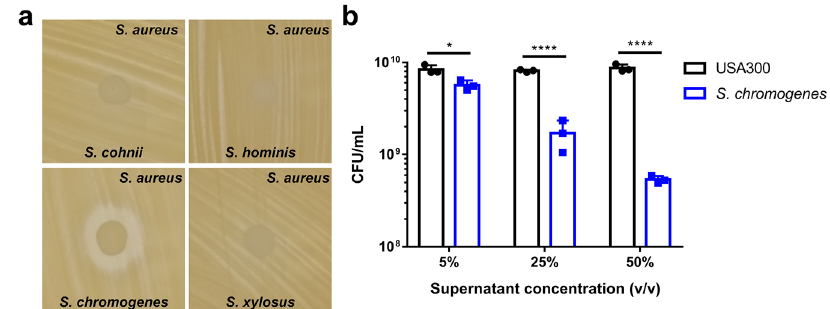
Fig. 1 S. chromogenes secretes a molecule that inhibits S. aureus growth. a Simultaneous antagonism assay of selected representative CoNS on TSA. b S. aureus was cultured in TSB containing spent culture supernatant from S. chromogenes or S. aureus . The bacteria were grown for 24 h before they were plated and CFU/mL were enumerated. Results are pooled from three independent experiments. Data are shown as mean ± SD ( n = 3, * p ≤ 0.05, **** p ≤ 0.0001. Two-sided unpaired t -test).